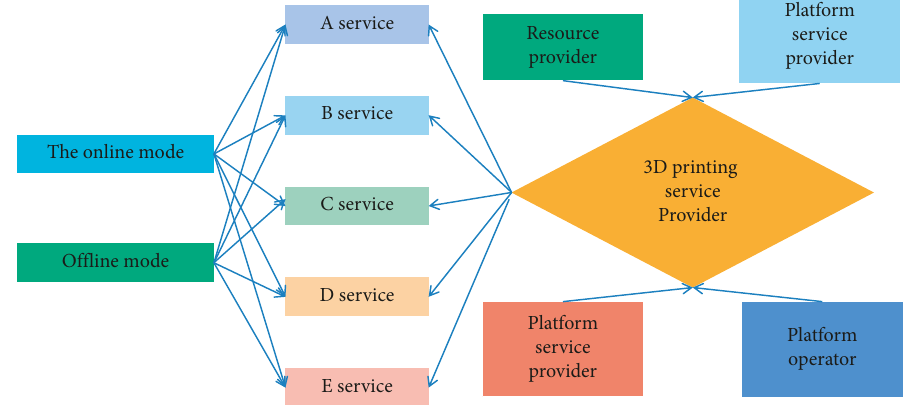
Figure 4: 3D platform operation mode.